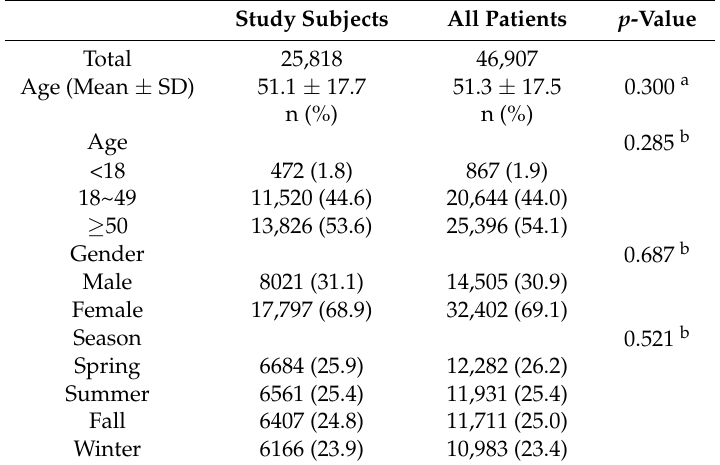
a two sample t -test; b chi-square test.